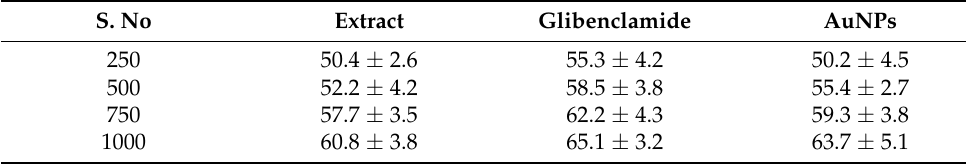
Table 7. Percent antidiabetic potency of extract, glibenclamide and AuNPs. S.